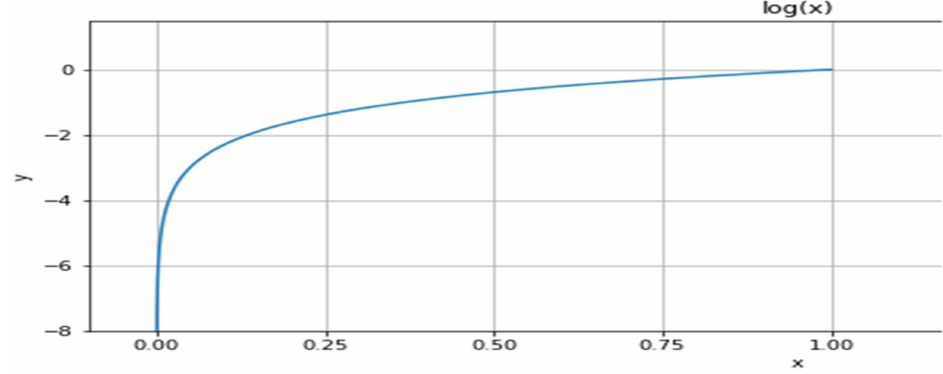
Figure 10. Log loss score versus probability distribution for the SentiChurn